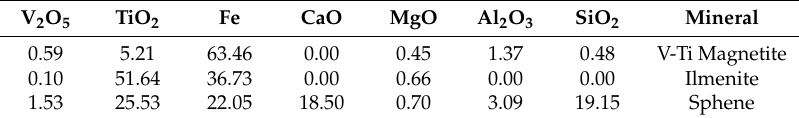
Table 6. The results of average of raw sample by SEM-EDS analyses (wt %).